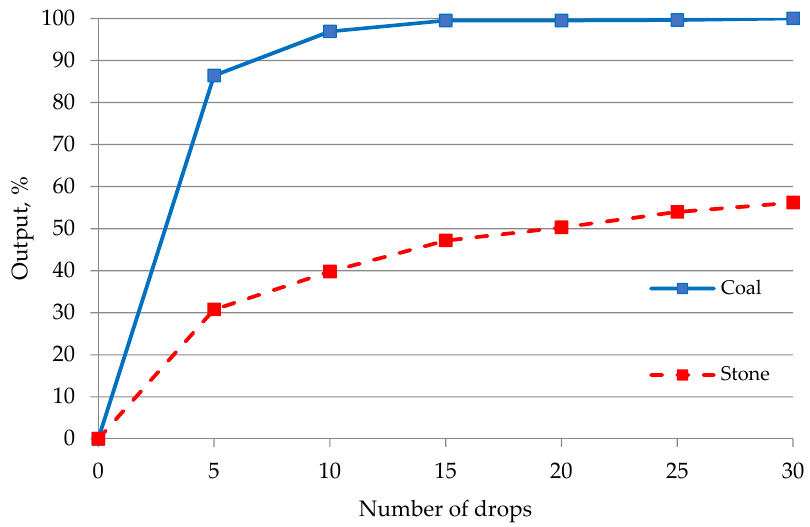
Figure 5. Comparative results of the 80-0 mm class output depending on the number of drops (coal type 35) [43].